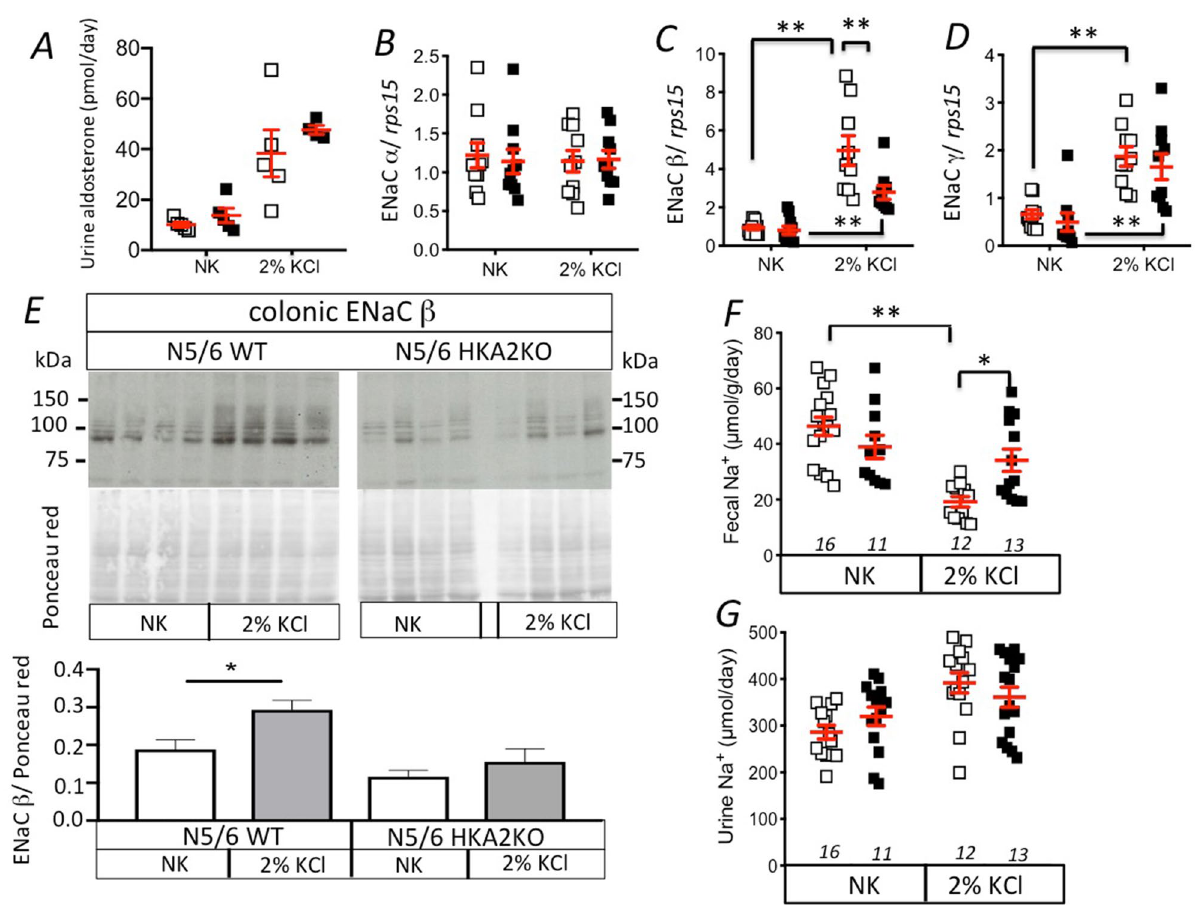
Figure 4. Colonic ENaC expression and fecal Na + excretion are also altered in N5/6 HKA2KO mice. ( A ) Daily urine aldosterone excretion in N5/6 WT (white squares) and N5/6 HKA2KO (black squares) mice under normal (NK) or high K + intake (2% KCl). Results are shown as the mean ± s.e.m, n = 5. ( B – D ) mRNA expression of ENaC α, β and γ subunits in N5/6 WT (white squares, n = 10) and N5/6 HKA2KO (black squares, n = 10) mice under normal (NK) or high K + intake (2% KCl). Results are shown as the mean ± s.e.m. ( E ) higher panel , Immunoblot of the ENaC β subunit in N5/6 WT (white squares, n = 4) and N5/6 HKA2KO (black squares, n = 4) mice under normal (NK) or high K + intake (2% KCl). Middle panel , Ponceau red labeling of the membrane. Lower panel , quantification of the band intensity normalized with the Ponceau red labeling. ( F ) Fecal excretion of Na + in N5/6 mice under normal (NK) or high K + intake (2% KCl). ( G ) Urine excretion of Na + in N5/6 mice under normal (NK) or high K + intake (2% KCl). Results are shown as the mean ± s.e.m. Numbers in italic = n of mice. Two-way ANOVA test followed by a Sidak’s multiple comparisons test, (** p < 0.01; * p < The absence of the HKA2 limits the colonic Na + absorption by modulating ENaC expres‑ sion. Aldosterone is a steroid hormone that is involved in both K + and Na + balances 48 . The decrease of the K + sensitivity in N5/6 HKA2KO mice may result in changes of aldosterone level and Na + homeostasis. As shown in Fig. 4A, the aldosterone levels of N5/6 WT and HKA2KO mice are similar in normal conditions and are similarly increased (4-times) by a K + load. Despite this similar level in aldosterone, we observed differences in the colonic expression of ENaC subunits between WT and HKA2KO mice. As shown in Fig. 4B–D, the mRNA expression of the ENaC α subunit was similar in N5/6 WT and HKA2KO mice whatever the K + intake and that of the ENaC γ subunit was similarly increased by K + loading in N5/6 WT and HKA2KO mice. Regarding the ENaC β subunit, its mRNA expression in the colon of N5/6 WT and HKA2KO mice was differentially stimulated by K + intake. Indeed, it was significantly 2 times lower in HKA2KO mice than in WT mice ( p < 0.01). At the protein level, we confirmed that the level of the β subunit of ENaC was upregulated in N5/6 WT mice after K + loading, which was not the case in N5/6 HKA2KO mice (Fig. 4E). As shown in Fig. 4F, in nephrectomized mice, the fecal Na + excretion is similar between WT and HKA2KO mice under the normal K + diet. In N5/6 WT mice, K + loading induced a 2.5-fold decrease in fecal Na + excretion whereas N5/6 HKA2KO mice did not display any modification of their fecal Na + excretion. The absence of HKA2, therefore, impedes colonic Na + retention in response to nephrectomy and K + loading.